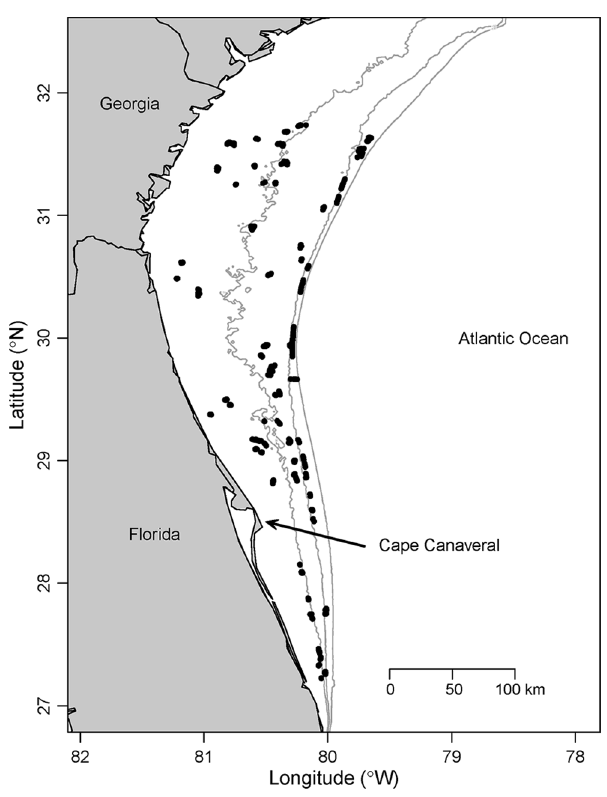
Figure 1. Study area with dots marking sampling locations. The offshore contours are depth isoclines at 30 m, 50 m, and 100 m.